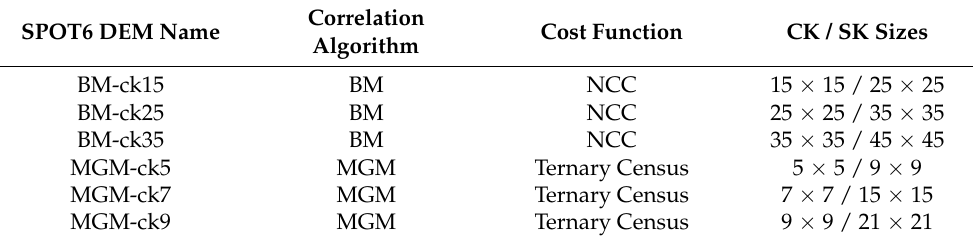
Table 1. Parameters and names used herein for the SPOT6 DEMs. All DEMs were generated using the AC pair and output to 3 m resolution; BM = Block Matching; MGM = More Global Matching; NCC = Normalized Cross Correlation; CK = Correlation Kernel; SK = Sub-pixel Kernel. Correlation SPOT6 DEM Name